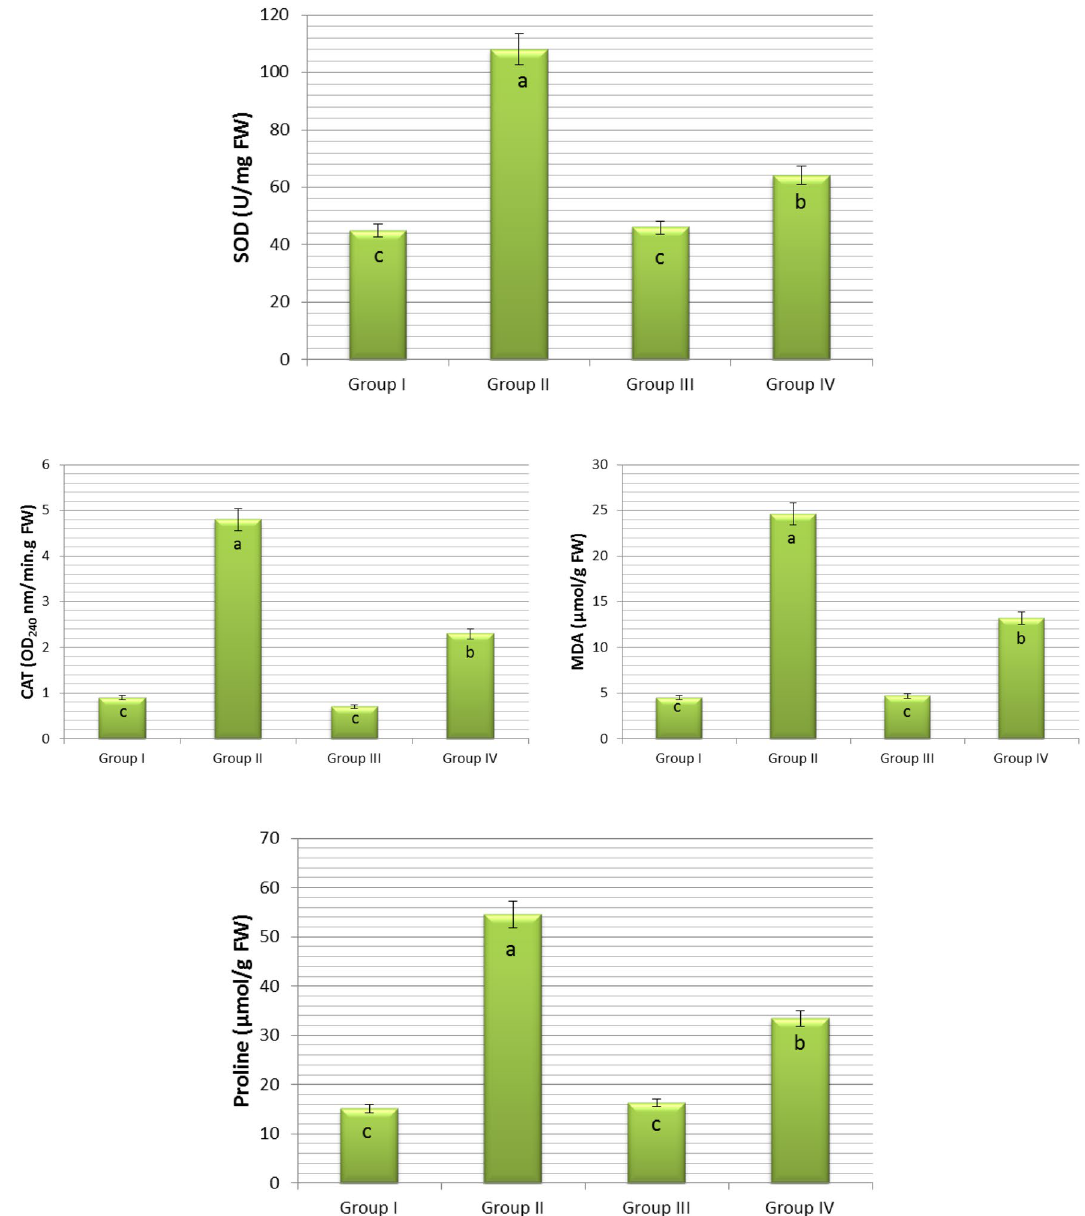
Figure 4. Effect of COR on some biochemical parameters of Allium cepa L. Group I (control) was treated with tap water; Group II was treated with 0.15 M NaCl; Group III was treated with 0.01 µM COR; Group IV was treated with 0.01 µM COR + 0.15 M NaCl. The error bars indicate the standard deviation (±